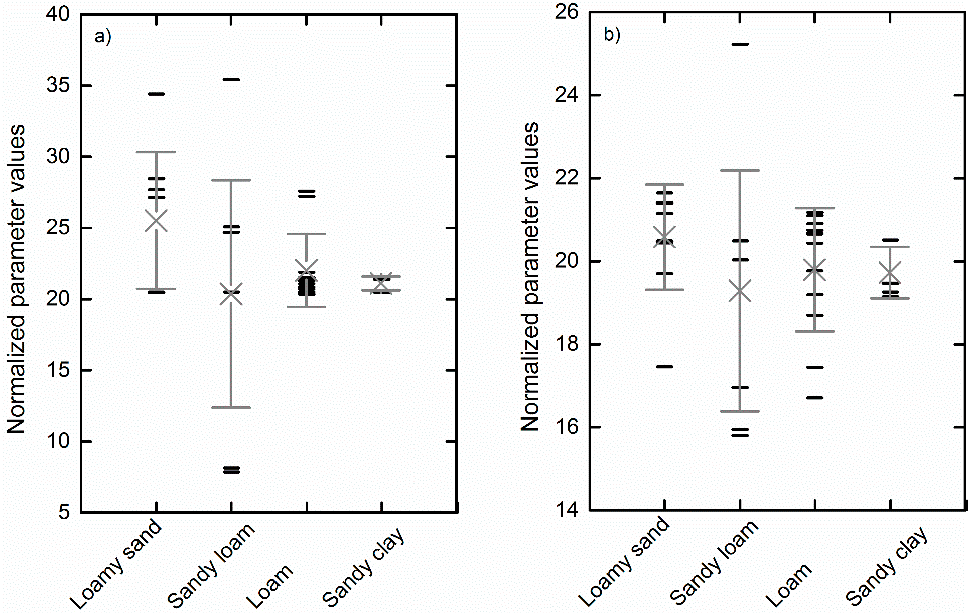
Figure 6. Posterior (i.e., optimized) values for soil texture dependent parameters related to soil water processes, ( a ) s b for different soil textures; ( b ) s n for different soil textures. Normalization and symbols as in Figure 4.